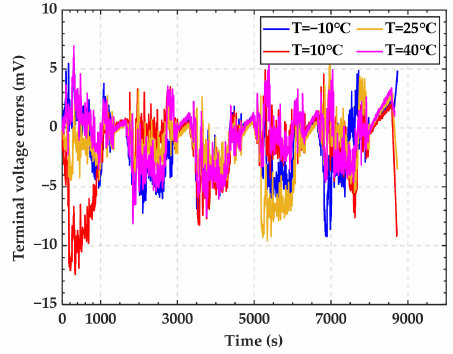
Figure 2. The terminal voltage error